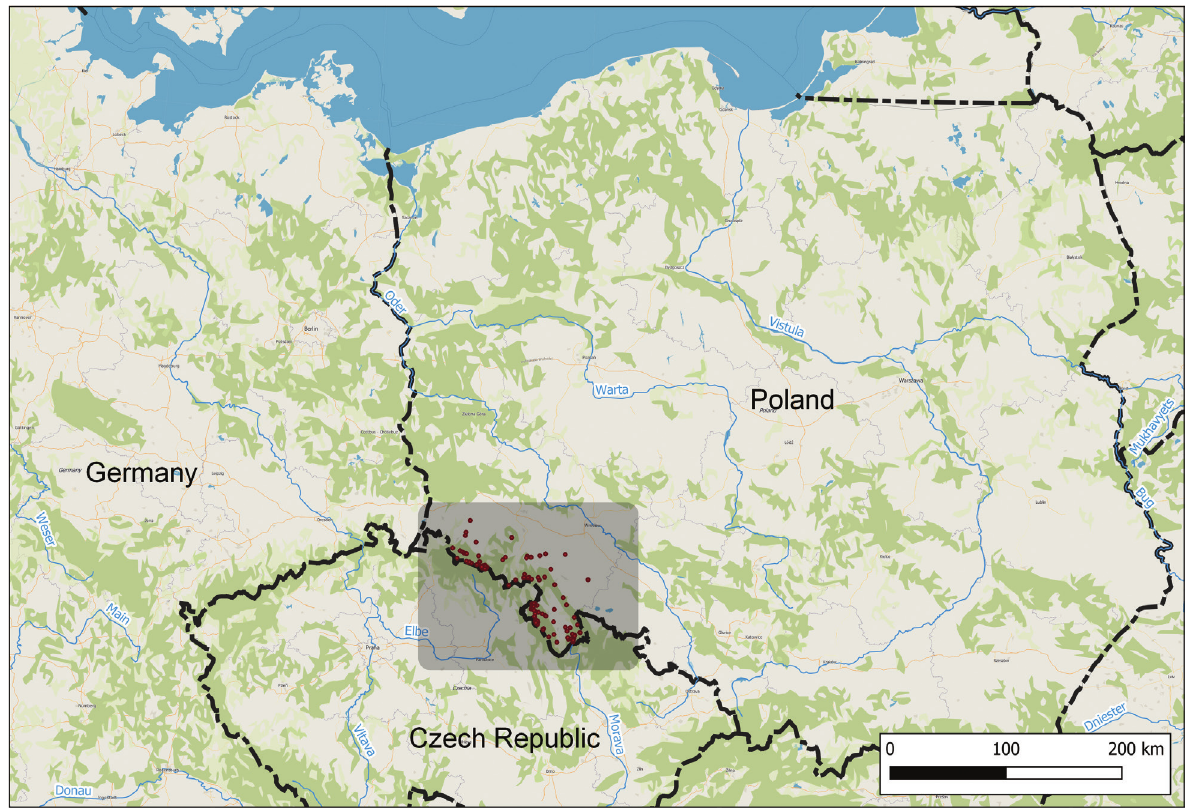
Figure 1. Area of the investigation. Red dots show the distribution of the analyzed relevés of tall-herb communi- ties ( n = 399) in SW Poland (gray rectangle). Forests are marked in green. Background from © MapTiler © Open- StreetMap